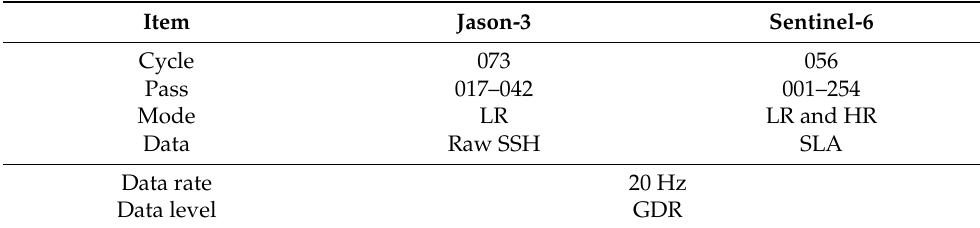
Table 1. The dataset information of Jason-3 and Sentinel-6 used for noise-level estimation. Item Jason-3 Cycle 073